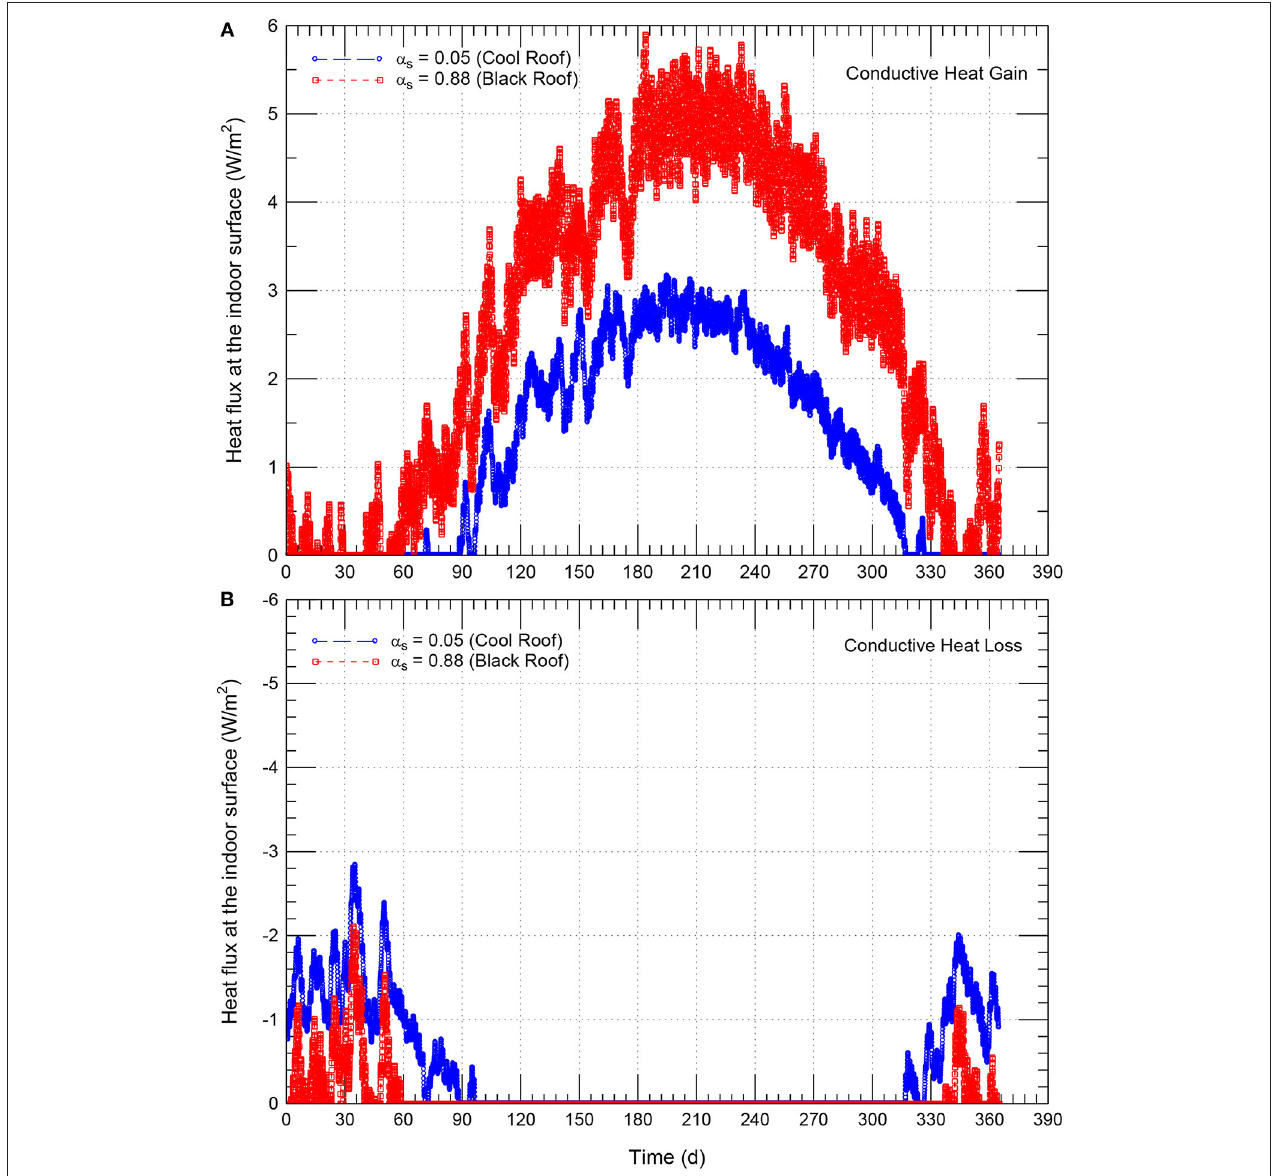
FIGURE 10 | Comparison of hourly heat flux at the indoor surface due to conductive heat gain (A) and conductive heat loss (B) of conventional/black roof ( α s = 0.88) and cool roof ( α s = 0.05) for 1 ins = 152mm (6.0 inch).